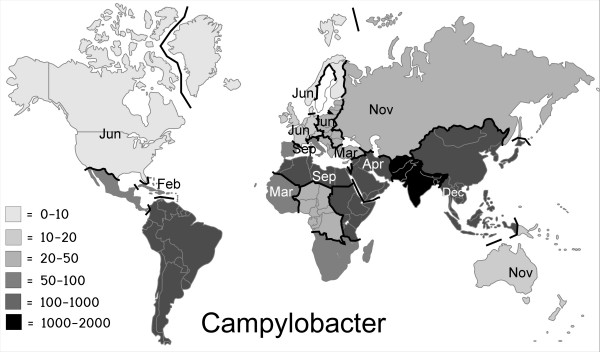
Map showing Campylobacter risk per 100 000 returning travellers to Sweden from different regions of the world. In regions with a distinct seasonality, the month with the highest risk (OR) is given.